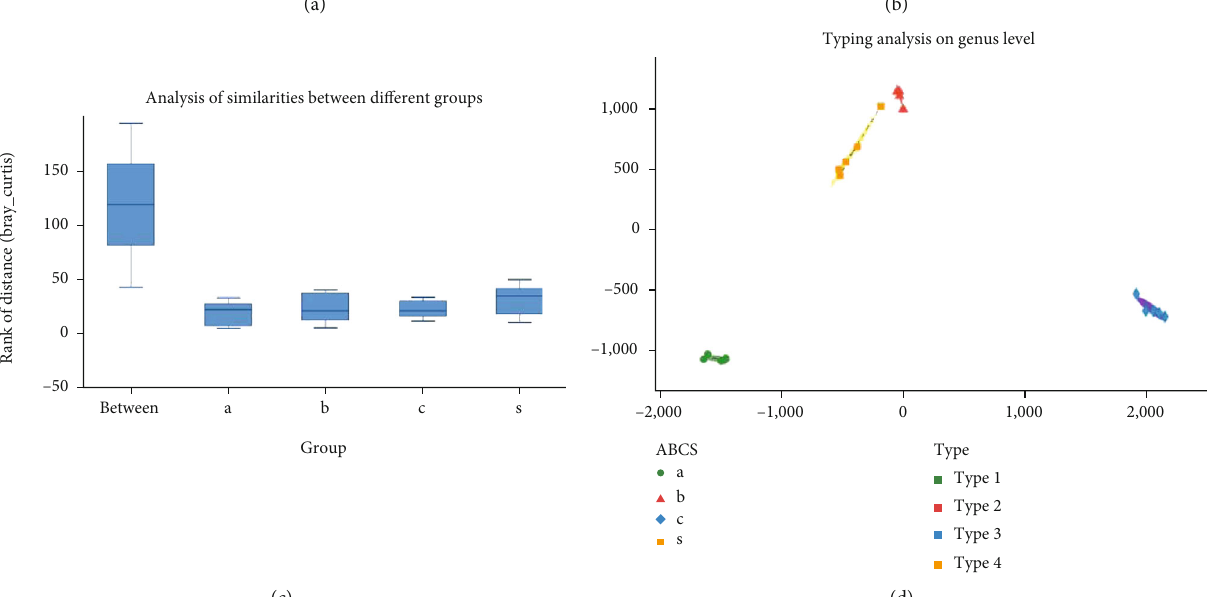
Figure 3: (a) Cluster analysis, (b) principal coordinates analysis, (c) analysis of similarities, and (d) typing